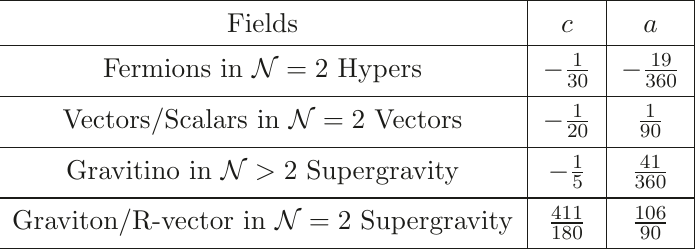
Table 2 . Central charges c and a for some nontrivial fields in entry has a total of four degrees of